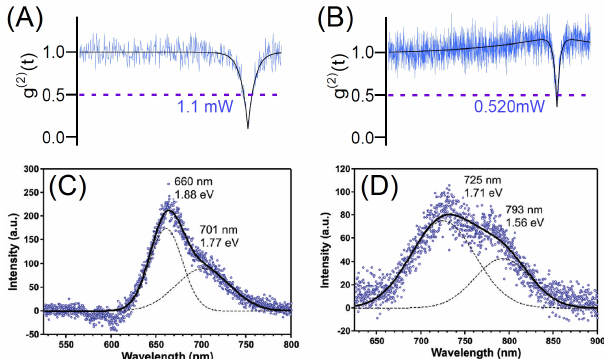
Figure 3: Characterization of single-photon emitters in ZnO. (A, B) Representative g 2 ( τ ) curves from 2 different defects acquired for several different laser powers. In each curve, the antibunching dip at ( g 2 ( τ ) = 0) is observed, verifying that a single defect is being studied. Note in (B) that as laser power increases, the antibunching dip sharpens and bunching behavior ( g 2 ( τ ) > 1) is evident indicating three-level system exists. (C, D) Background subtracted, single- defect fluorescence showing two broad emission lines in each case. The dash lines are fit by gaussian function to each emission line, while the thick black line is the sum of the two gaussian peaks. Reproduced with permission from Ref. [10] (A, B) and [9] (B,